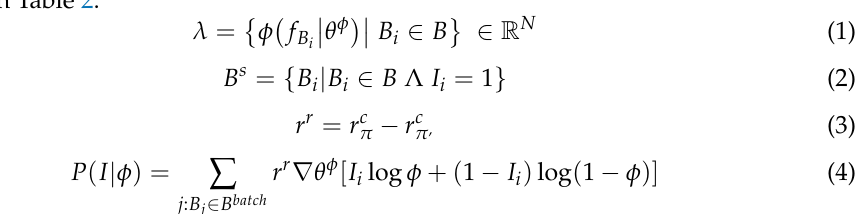
Figure 2. An illustration of experience replay optimisation (ERO). A specified batch size of transi- tions is sampled from the replay buffer, using a replay policy (deep neural network), to train the agent. When the buffer is full, the First-In-First-Out (FIFO) retention strategy is applied to ensure that older transitions are replaced with newer ones. Table 2. Symbols and notations used in this section. Notation